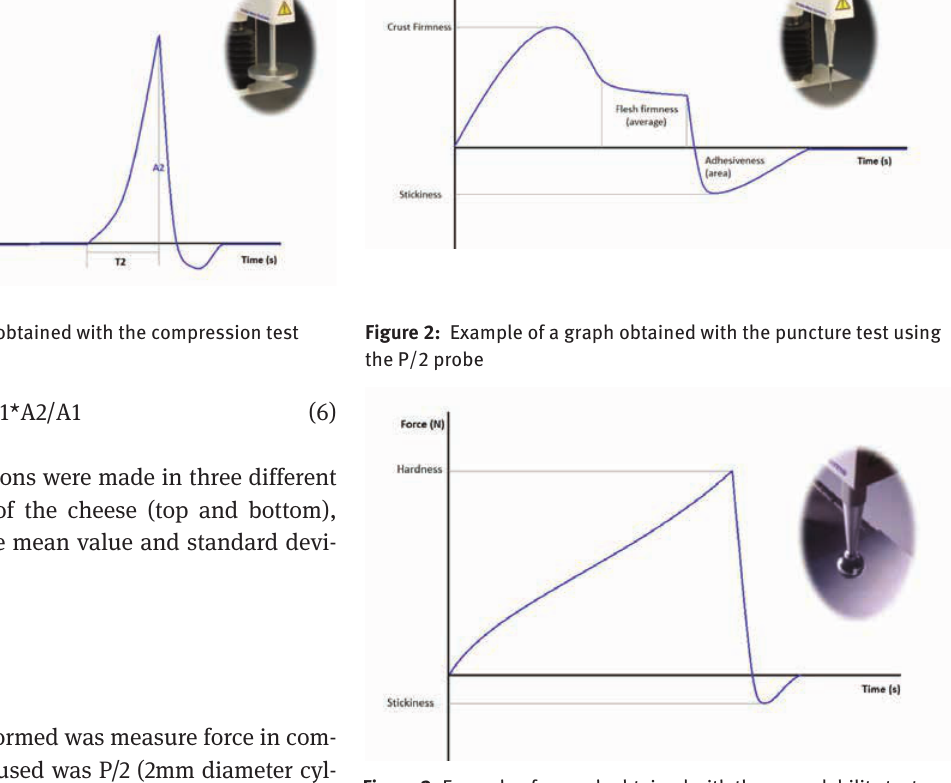
Figure 3: Example of a graph obtained with the spreadability test using the P/1S